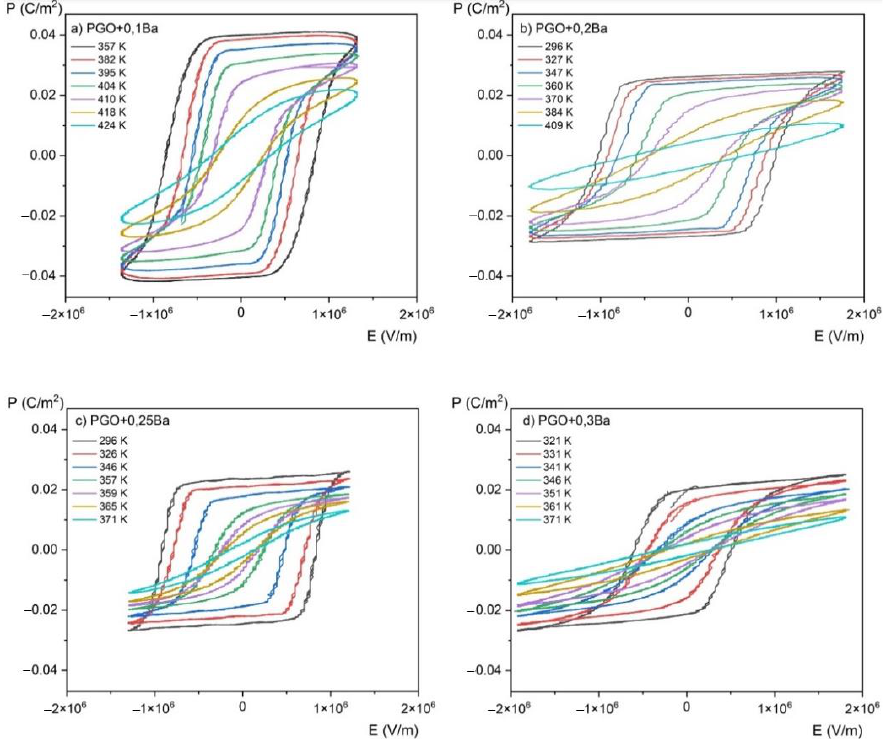
Figure 7. P ( E ) (polarization-electric fields) hysteresis loops as a function of the temperature for PGO